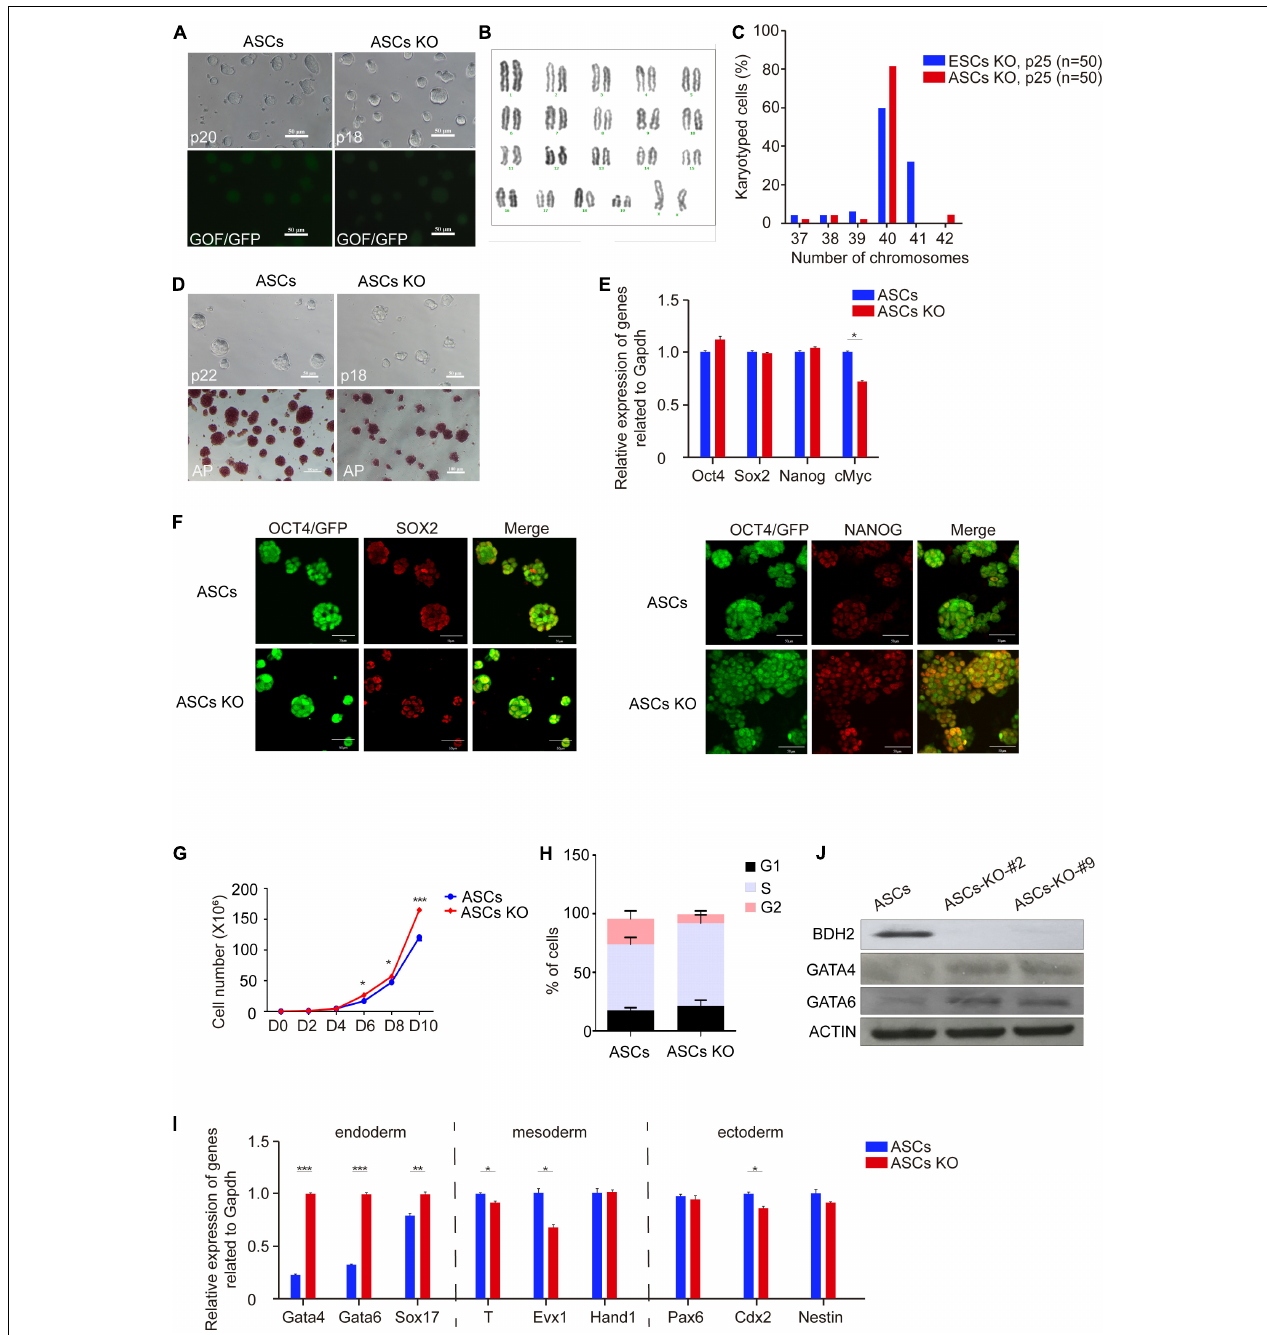
FIGURE 2 | Characteristics of Bdh2 -knockout ASCs. (A) Morphology of Bdh2 -knockout ASCs. Here, we use ASCs with GOF/GFP reporter. Scale bars, 50 µ m. (B) Karyotyping of Bdh2 -knockout ASCs (P25). (C) Distribution of chromosome number in Bdh2 -knockout ASCs (P25) and Bdh2 -knockout ESCs (P25). (D) Alkaline phosphatase (AP) staining on Bdh2 -knockout ASCs and ASCs. Scale bars, 50 µ m. (E) Real-time PCR analysis of pluripotency-associated genes expression in the Bdh2 -knockout ASCs, ASCs were used as control. Data were obtained in triplicate and presented as mean ± SD. p -values were calculated by two-way ANOVA, * p < 0.05, ** p < 0.001, *** p < 0.0001. (F) Immunostaining of SOX2 and NANOG in Bdh2 -knockout ASCs and ASCs. Scale bars, 50 µ m. (G) Cell proliferation curves in Bdh2 -knockout ASCs and ASCs. Data were obtained in triplicate and presented as mean ± SD. p -values were calculated by two-way ANOVA, * p < 0.05, ** p < 0.001, *** p < 0.0001. (H) Cell cycle analysis of Bdh2 -knockout ASCs and ASCs. The percentage of cells in G1, S, and G2 phase were determined by flow cytometry. Values are means of three independent experiments. Error bars indicate mean ± SD. (I) Real-time PCR analysis of endoderm, mesoderm, and ectoderm-associated genes expression in the Bdh2 -knockout ASCs, ASCs were used as control. Data were obtained in triplicate and presented as mean ± SD. p -values were calculated by two-way ANOVA, * p < 0.05, ** p < 0.001, *** p < 0.0001. (J) Western blotting was used to detect the expression of BDH2, GATA4, and GATA6 in Bdh2 -knockout ASCs and